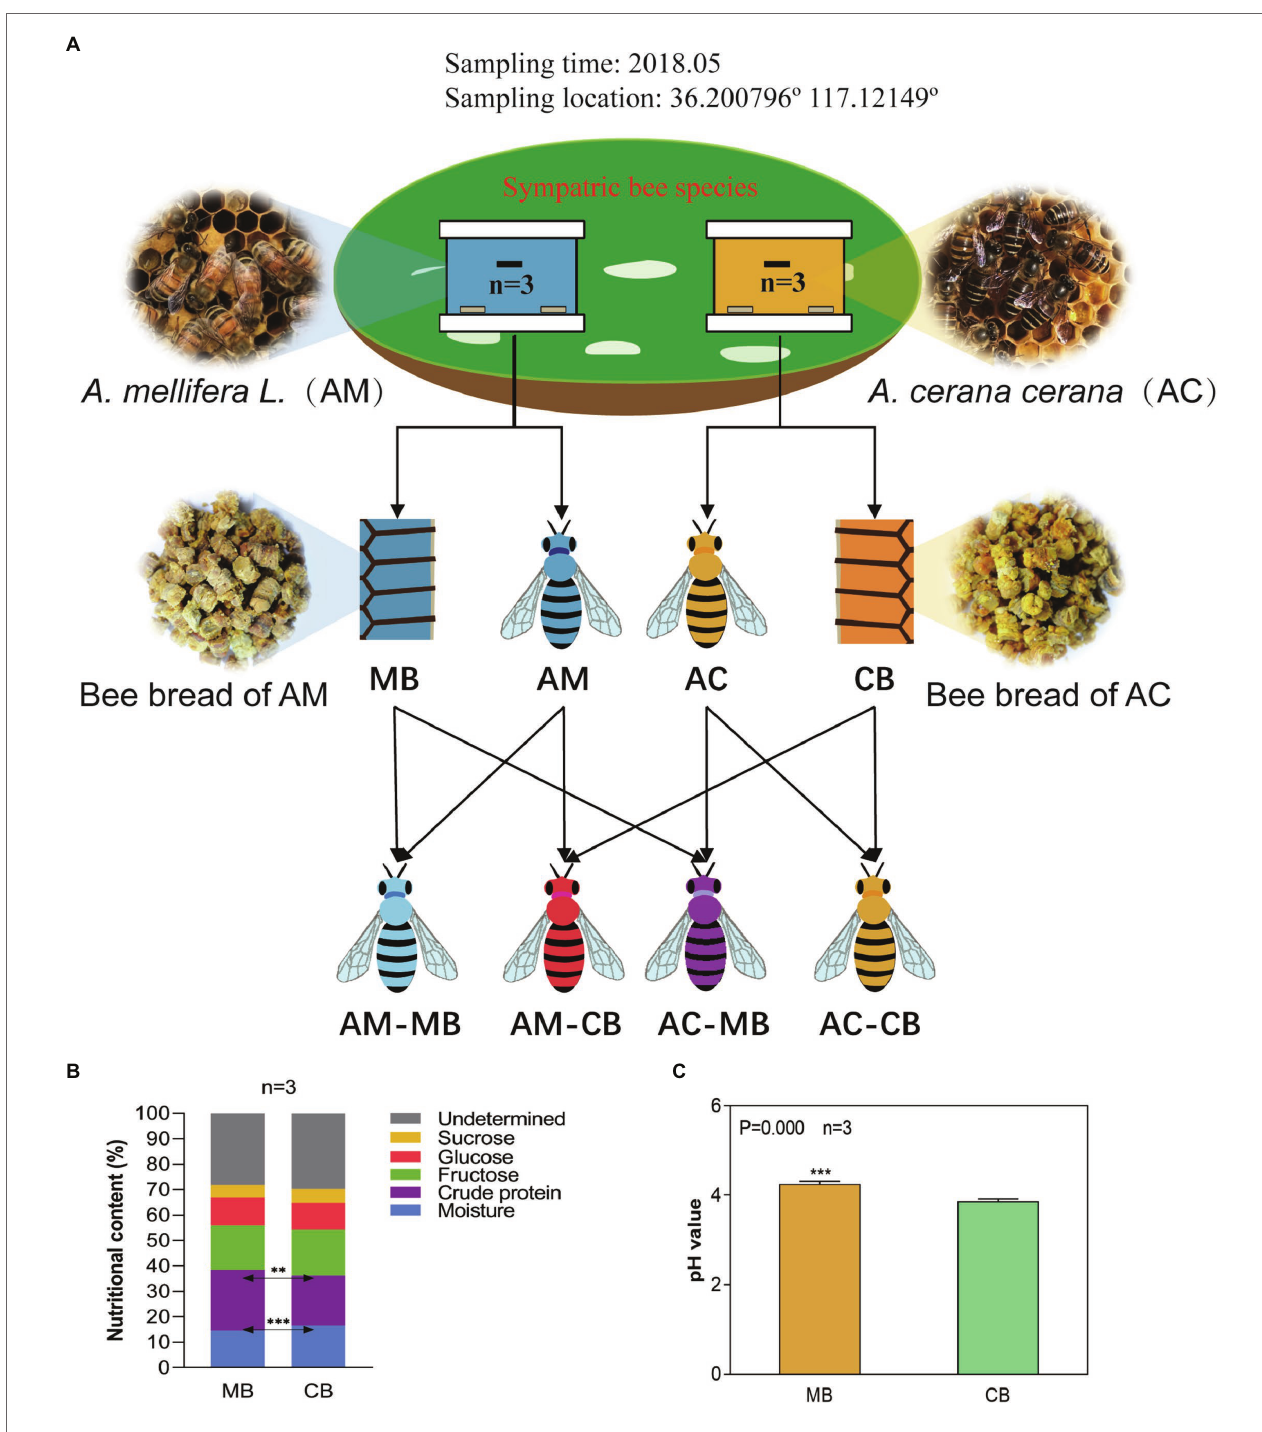
FIGURE 1 | Experimental design (A) and the comparison of the chemical composition (B) and pH (C) of bee bread made by Apis cerana and Apis mellifera . (A) Experimental design: Honeybee and bee bread samples were obtained from sympatric Apis mellifera and Apis cerana colonies (three colonies of each